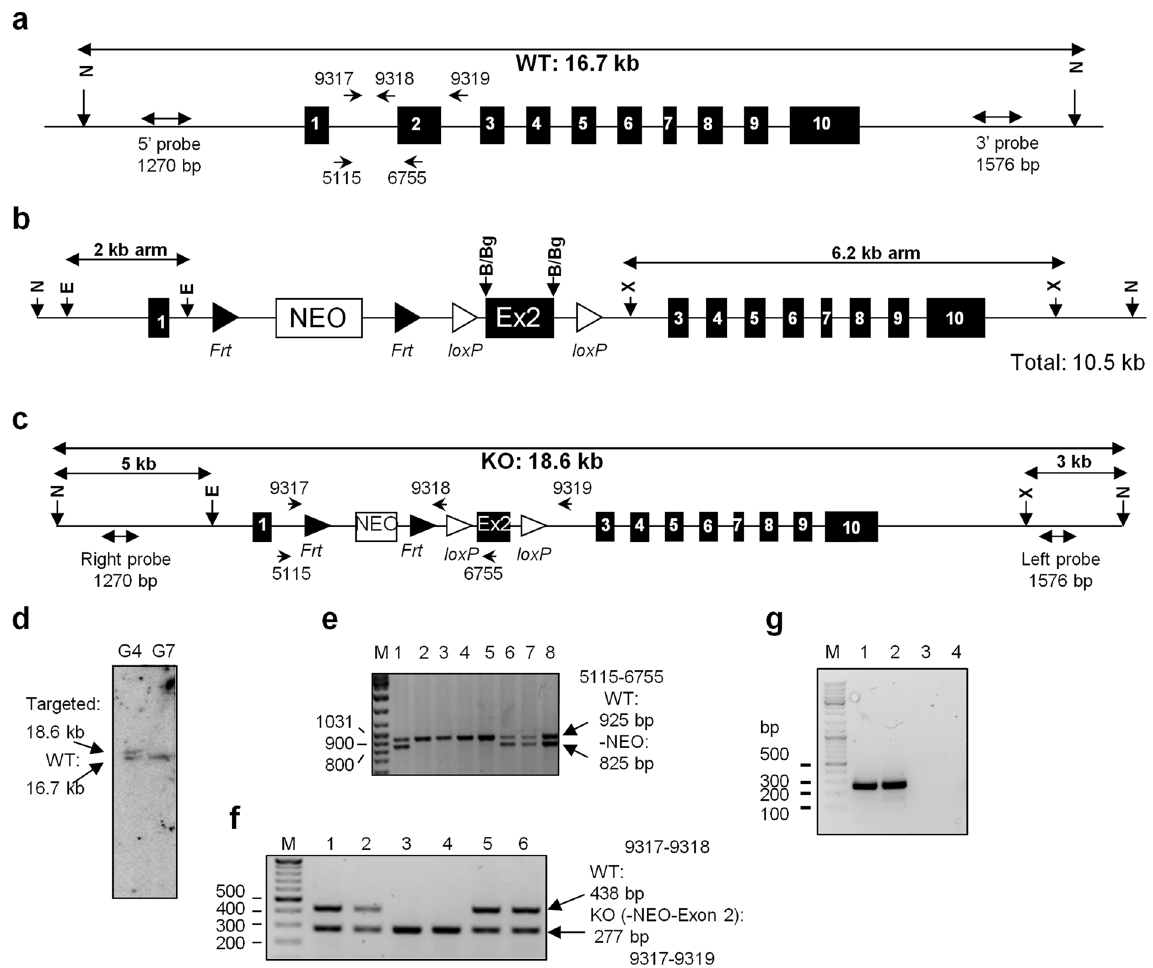
Figure 1. Targeted disruption of the murine Neil1 locus by conditional knockout strategy. ( a ) The Neil1 locus from the 129/SvJ mouse genome is shown. Exons, NdeI restriction enzyme sites, the position of the 5 ′ and 3 ′ probes used for Southern blotting and different primers used for genotyping during the generation of the Neil1 − / − mice, are indicated. ( b ) The targeting construct carried two homology arms (2 kb and 6.2 kb), floxed exon 2 (Ex2) and an FRT-flanked neo cassette (NEO). ( c ) The targeted Neil1 locus is shown. The positions of the 5 ′ and 3 ′ Southern blot probes are indicated. B and c The loxP sites are indicated by white triangles and the Frt sites are indicated by black triangles. Some restriction enzyme sites are shown; N: NdeI , E: EcoRI , B: BamHI , Bg: BglII , X: XhoI . ( d ) Southern blot analysis of DNA samples from two Geneticin-resistant ES clones digested with NdeI and hybridized with the 5 ′ probe identified a positive clone (G4). ( e ) Typical genotyping results obtained by PCR after breeding Neil1 + /floxneo mice with FLP recombinase expressing mice to remove the FRT-flanked neo marker. ( f ) Typical genotyping results obtained by PCR after breeding Neil1 + / flox mice with Cre recombinase expressing mice to remove the floxed exon 2 to generate Nei1l − / − mice. ( g ) Disruption of Neil1 expression in Nei1l − / − mice was measured by RT-PCR analysis of mRNA isolated from brain. 1 and 2: WT; 3 and 4: Nei1l − / −